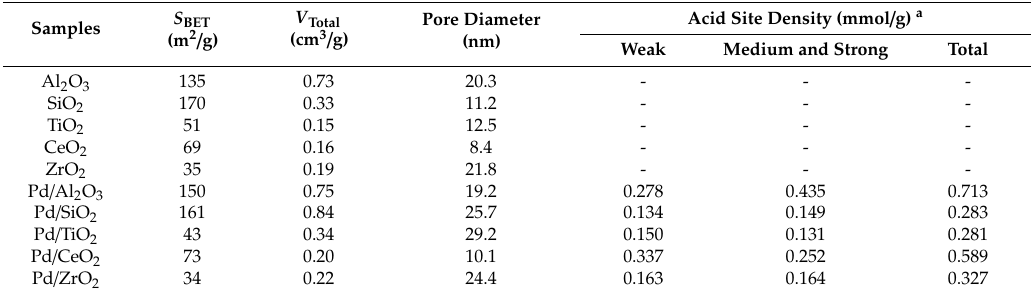
Table 1. Physicochemical properties of supports and Pd